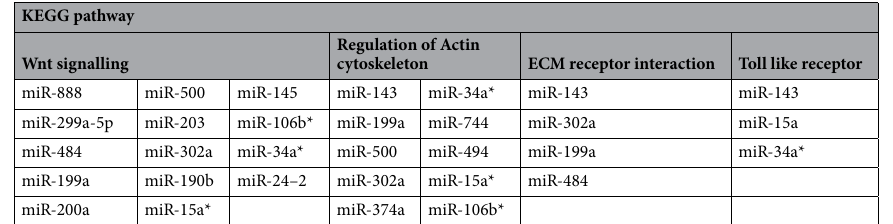
Table 2. Involvement of differentially regulated miRNA in KEGG cell pathways. In silico bioinformatic analysis of differentially regulated miRNA . Table shows KEGG pathways common to a number of differentially expressed miRNA and which are involved in platelet function. Permission was kindly granted by the Kanehisa Laboratory for the use of KEGG software.